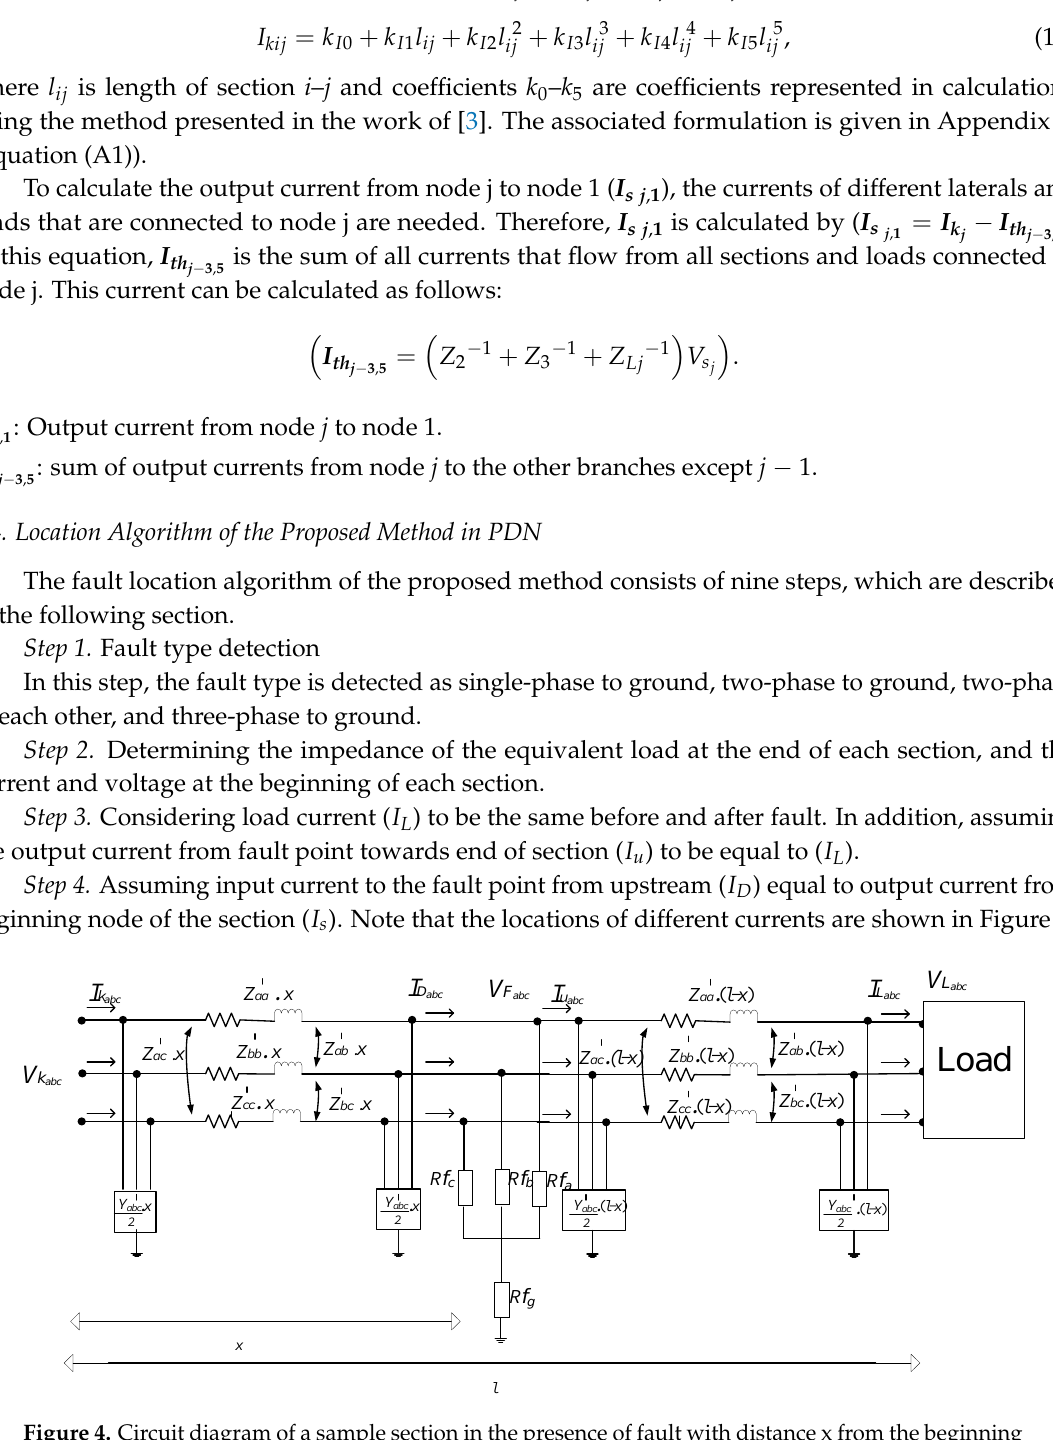
Figure 4. Circuit diagram of a sample section in the presence of fault with distance x from the beginning of the feeder.